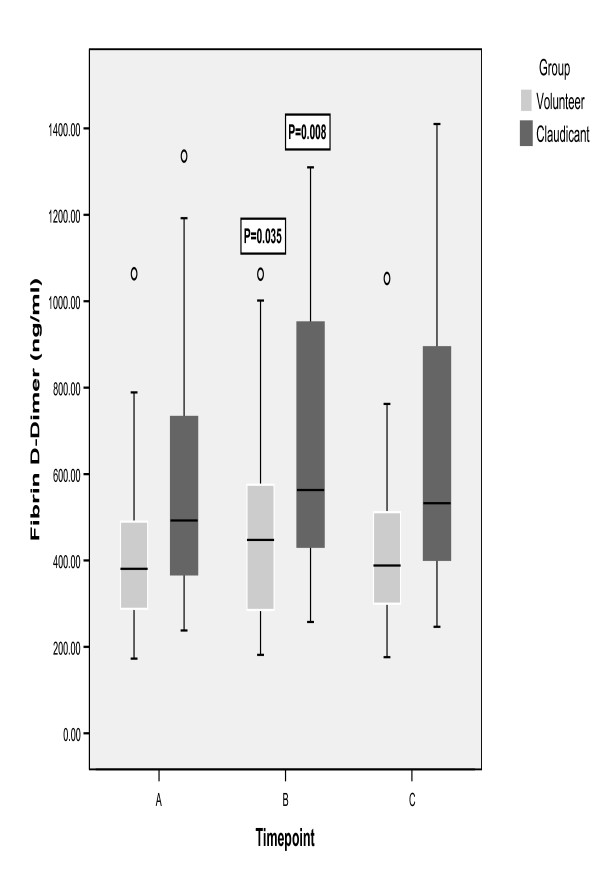
Plasma D-Dimer following treadmill exercise. A = baseline; B = immediately post-exercise; C = 1 hour post-exercise. Data presented as box-plots- line in centre of box represents the median value; the box represents the inter-quartile range and the whiskers represent the range. Markers out with the whiskers are outliers i.e. cases with values between 1.5 and 3 box lengths from the upper or lower edge of the box. P- values are Wilcoxon signed-rank test compared to baseline. Friedman test: P < 0.05